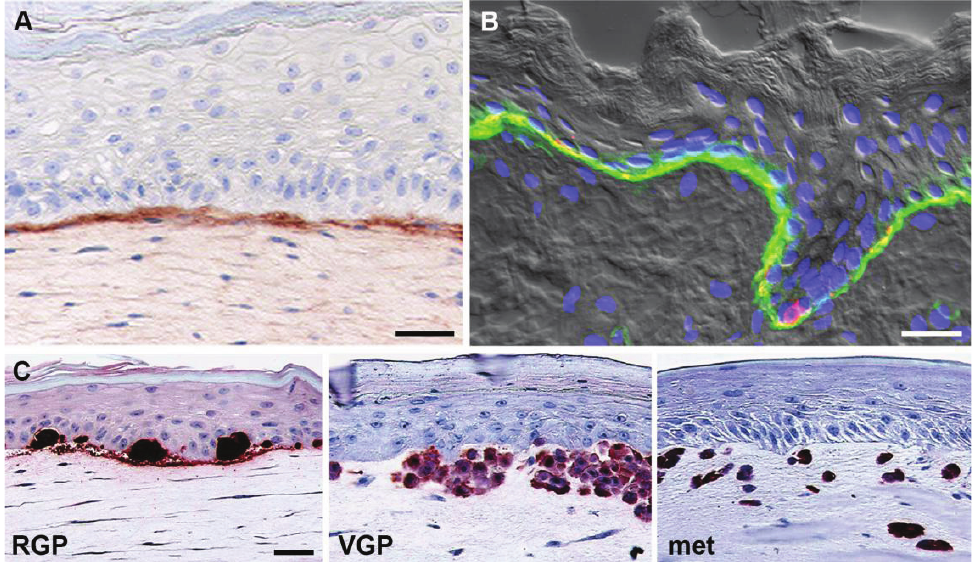
Figure 3. 3D skin reconstruct model. ( A ) Model: Keratinocytes and fibroblasts in human skin reconstructs produce a basement membrane (stained with a monoclonal antibody against collagen IV). Note the clear demarcation of the basement membrane; ( B ) Skin: Human fetal foreskin stained with a monoclonal antibody against α 6 integrin (green) and the melanocyte marker HMB45 (red), highlighting the continuous basement membrane between epidermis including basal keratinocytes and melanocytes (co-localization, yellow) and dermis. Note the similarity between model and original; ( C ) Melanoma cells recapitulate original tumor phenotype in reconstructed skin. Melanoma cells were stained for S100. Radial growth phase (RGP) melanoma cells proliferate and form nests in the epidermis, but do not invade the dermis. Vertical growth phase (VGP) cells cross the basement membrane, invade and proliferate in the dermis. Cells from metastatic (met) melanoma rapidly invade deep into the dermal compartment. Figure adapted from Haass et al ., 2005 [12] and Santiago-Walker et al. , 2009 [11]. Scale bar s: 30 μm